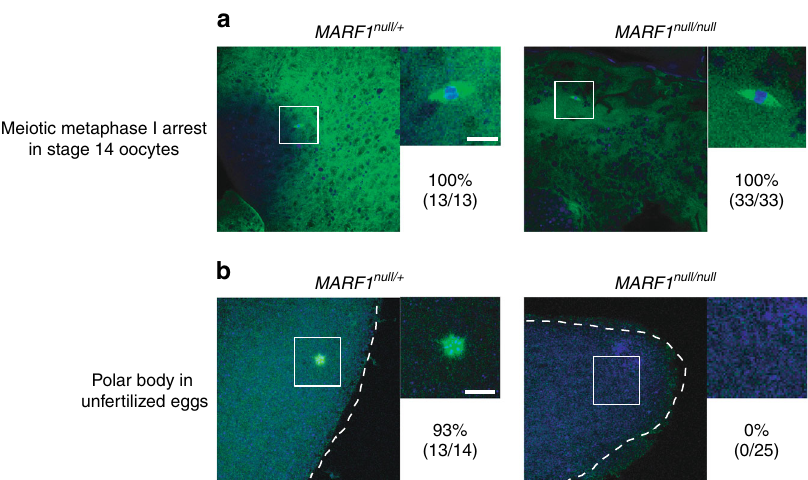
Fig. 3 MARF1 null eggs fail to complete meiosis. a Meiotic spindles show proper meiotic metaphase I arrest in control and MARF1 null stage 14 oocytes. The percentages of normal oocytes with proper meiotic spindle are shown. The numbers of normal oocytes with proper meiotic spindle/the numbers of observed oocytes are shown in parenthesis. Scale bar is 5 μ m. b Polar body shows completion of meiosis in control unfertilized eggs, but not in MARF1 null unfertilized eggs. Neither meiotic spindle nor polar body were observed in MARF1 null unfertilized eggs. The percentages of normal unfertilized eggs with a proper polar body are shown. The numbers of normal unfertilized eggs with a proper polar body/the numbers of observed unfertilized eggs are shown in parenthesis. Scale bar is 5 μ m. DNA was stained with DAPI (blue) and alpha-Tubulin was visualized with FITC-conjugated anti-alpha-Tubulin antibody